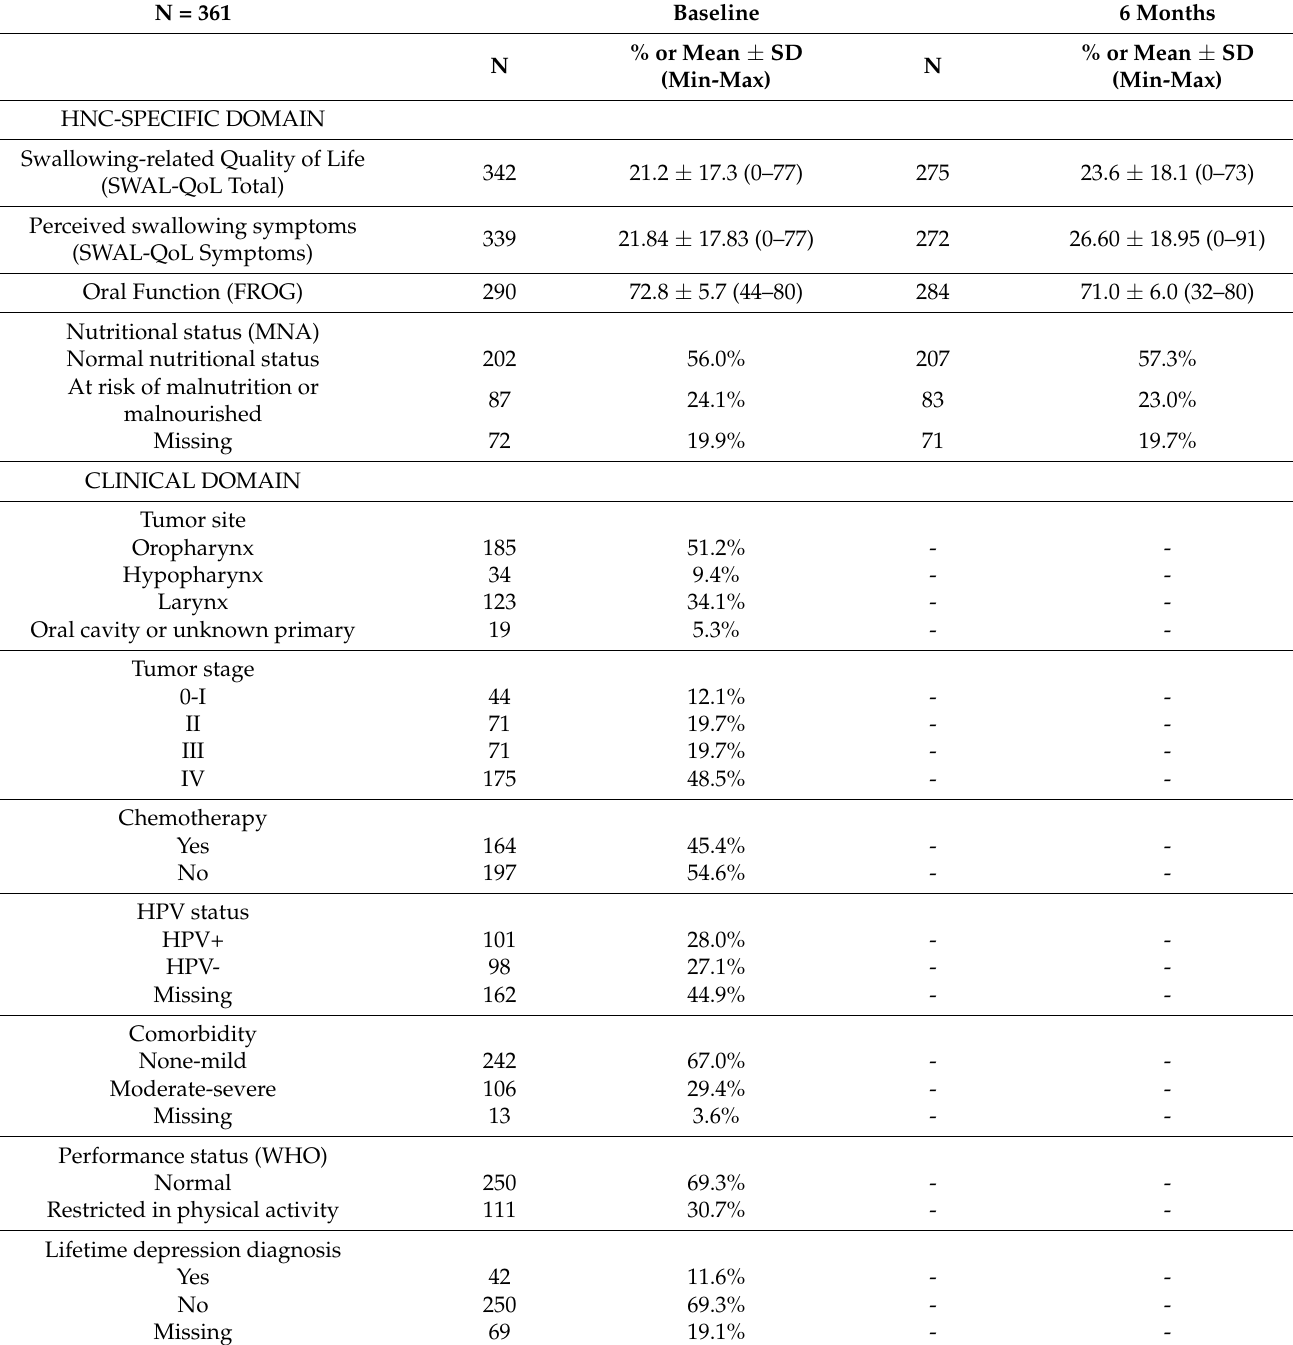
Table 1. Participants’ features at baseline and 6 months post